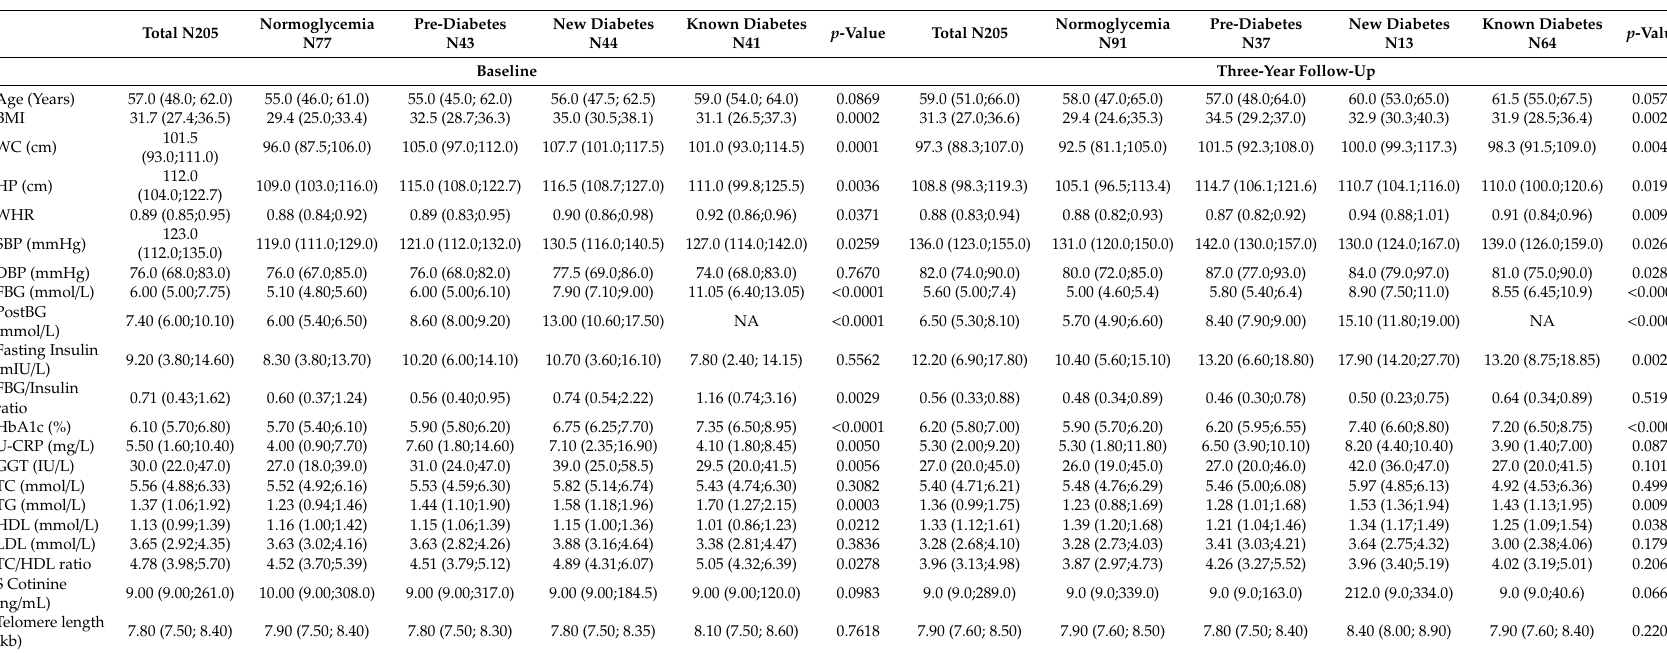
Table 1. Di ff erences in the biochemical and anthropometric measurements according to the glycemic profile: Baseline and three-year